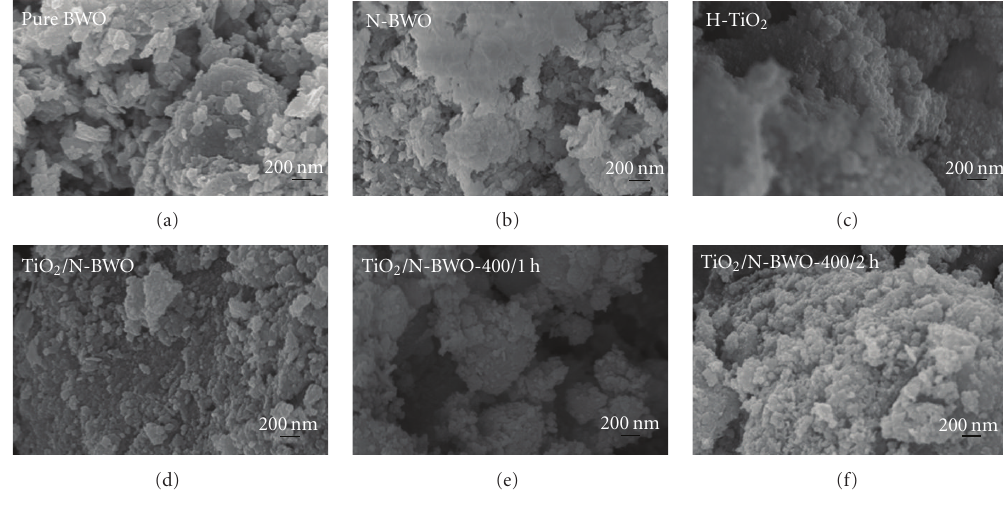
Figure 2: Selected SEM micrographs for the as-prepared samples.